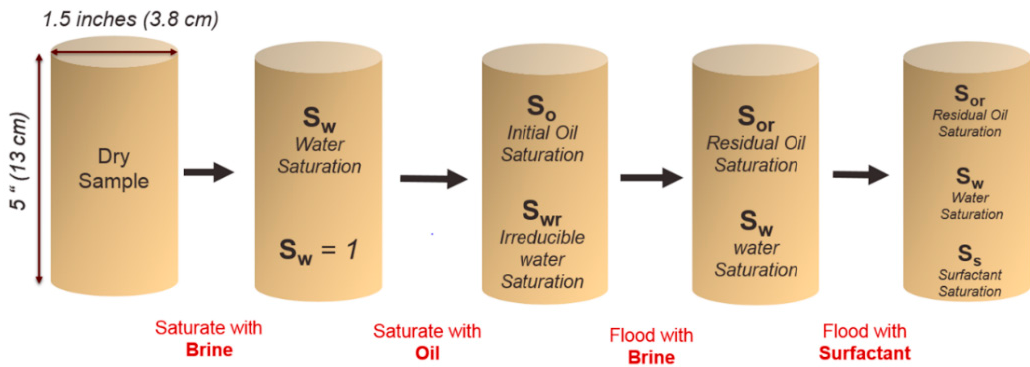
Figure 2. Experimental Procedure for flooding experiments.